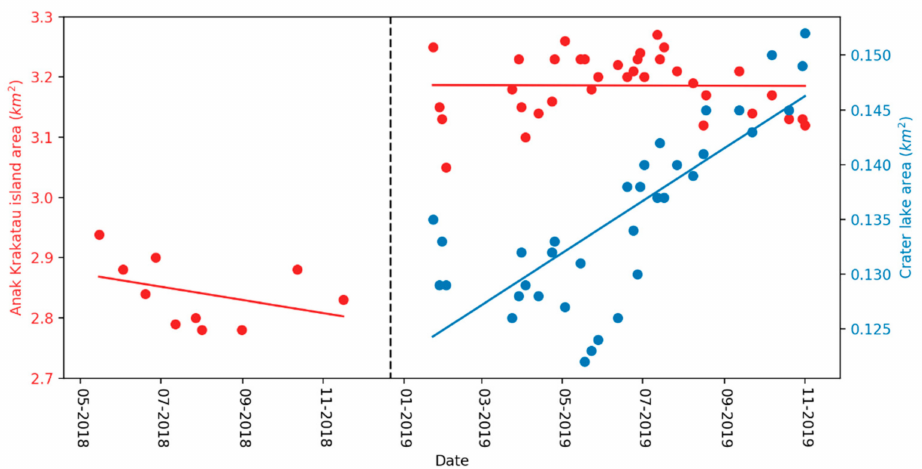
Figure 5. Change in the size of the AK land surface (red circle) and the crater lake (blue circles) before and after the December 2018 lateral collapse (dashed black line). The large time gap from early November 2018 to the end of January 2019 is due to the combined e ff ects of rainy-season cloud cover and the obscuring e ff ects of the eruption and associated atmospheric plumes in early